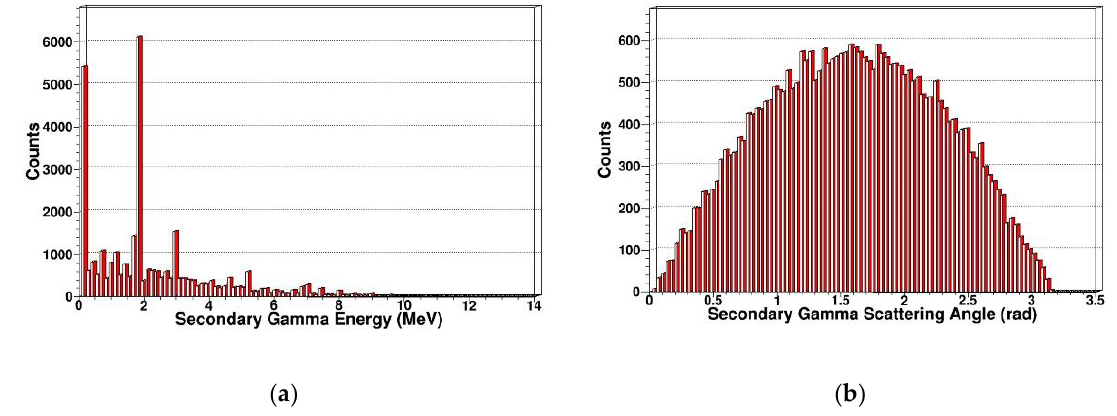
Figure 7. Secondary gammas in SDD generated by neutrons: ( a ) Energy spectrum of secondary gammas; ( b ) scattering angle distribution of secondary gammas.